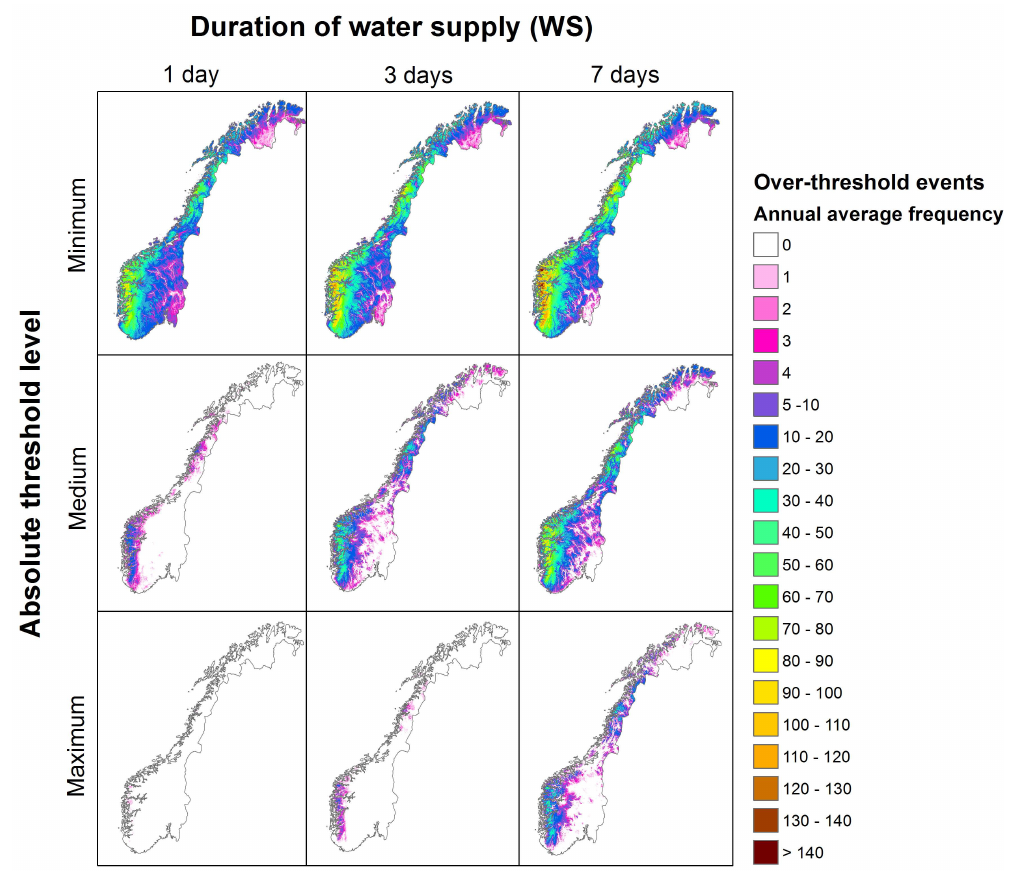
Fig. 7. Spatial distribution of the annual average frequency of over-threshold water supply events calculated from the absolute minimum, medium and maximum ID threshold for 1 day, 3 days and 7 days duration of water